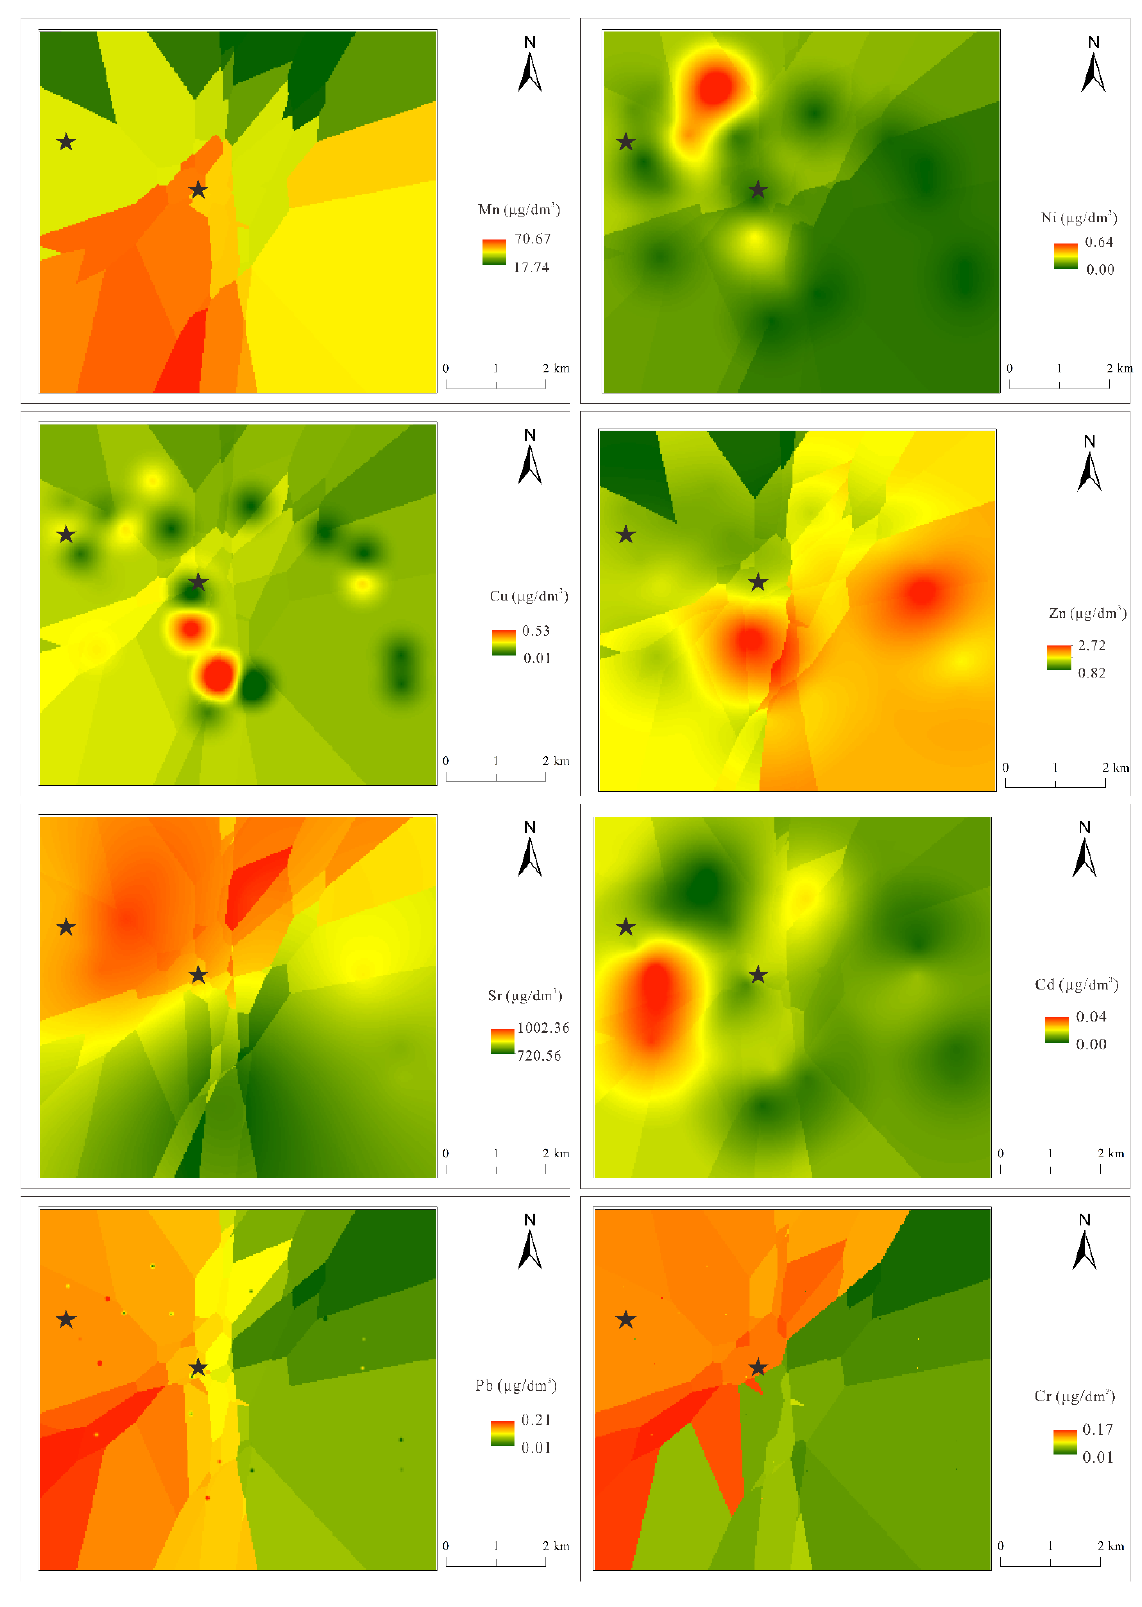
Figure 3. Spatial interpolation distribution of heavy metal concentrations in water samples (the asterisk in the figure represents the location of the poultry farm).